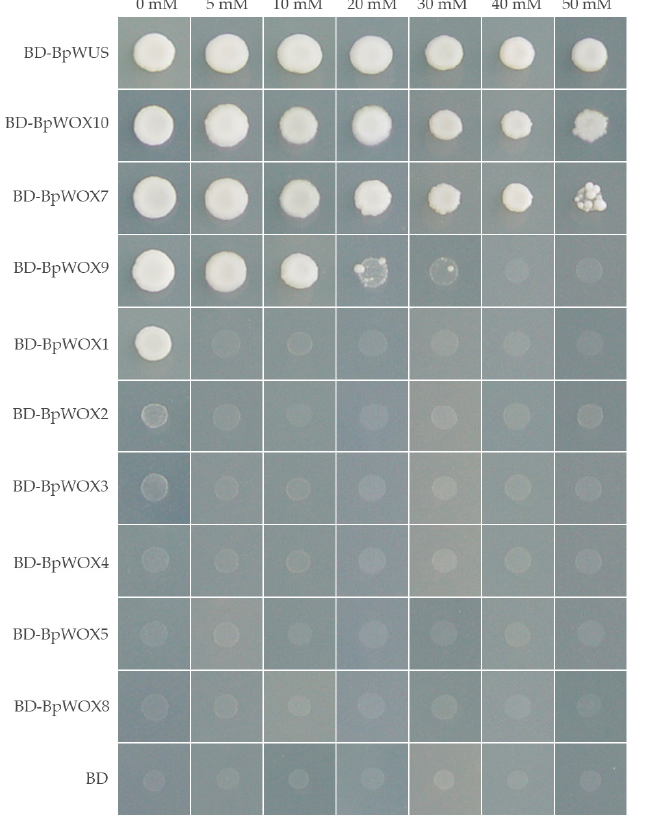
Figure 4. The transactivation activity of BpWOX family. The full-length ORF of each BpWOX gene was fused with p Bridge, and the transformed AH109 yeasts were selected from SD-Trp-His medium containing 0–50 mM 3-aminotriazole (3-AT), which is a competitive inhibitor of HIS3 protein. The empty p Bridge (BD) vector was used as a negative control.